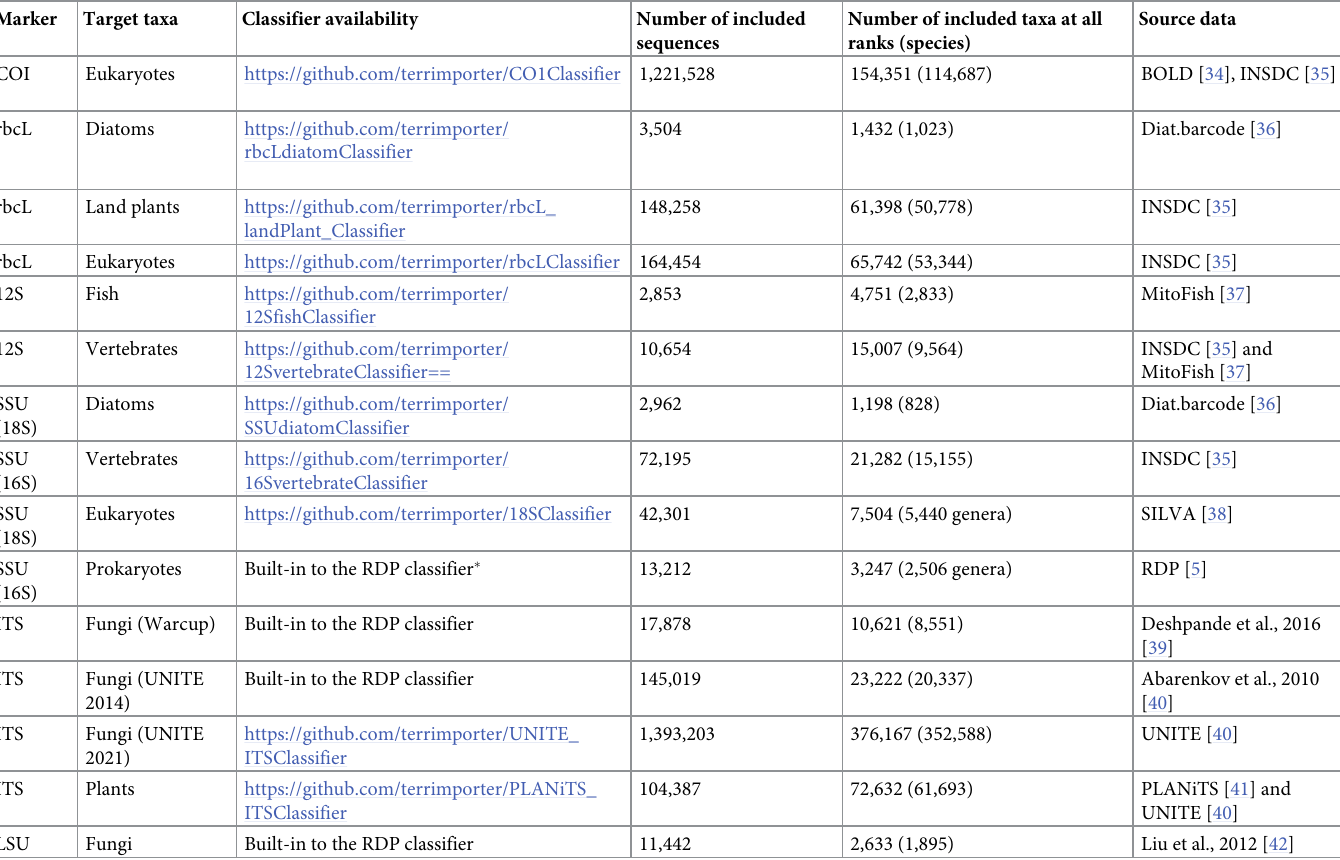
Table 1. RDP-trained reference sets that can be used with